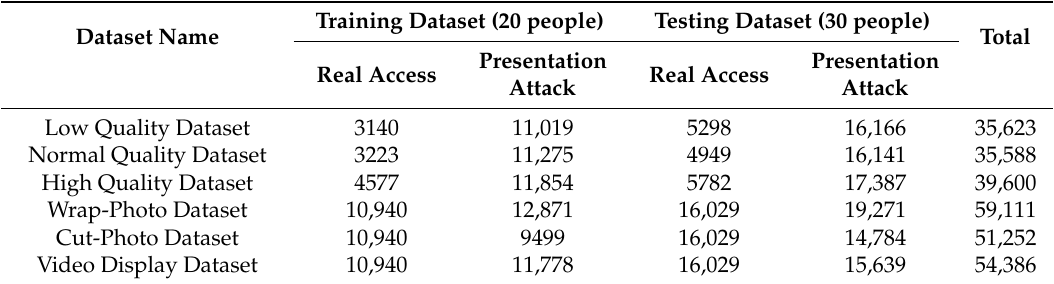
Table 7. Description of subsets of the CASIA dataset used in our study (unit: image sequences).